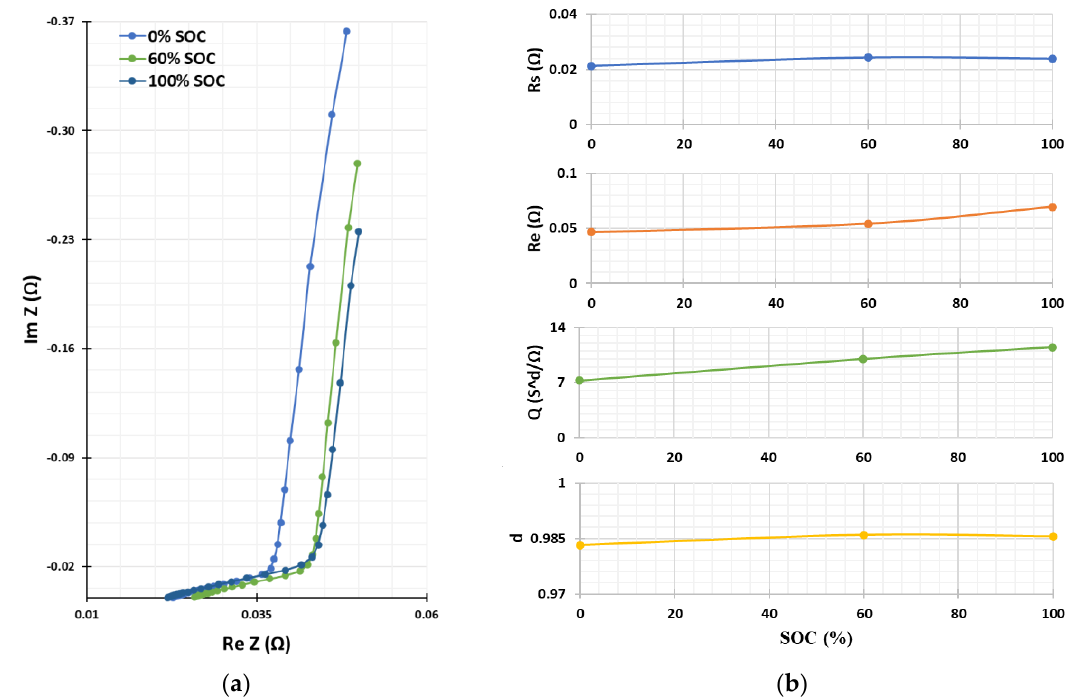
Figure 3. ( a ) Nyquist impedance plots of a supercapacitor (2.7 V 10 F) at 0%, 60% and 100% SOC ( b ) Parameters variation at each SOC.